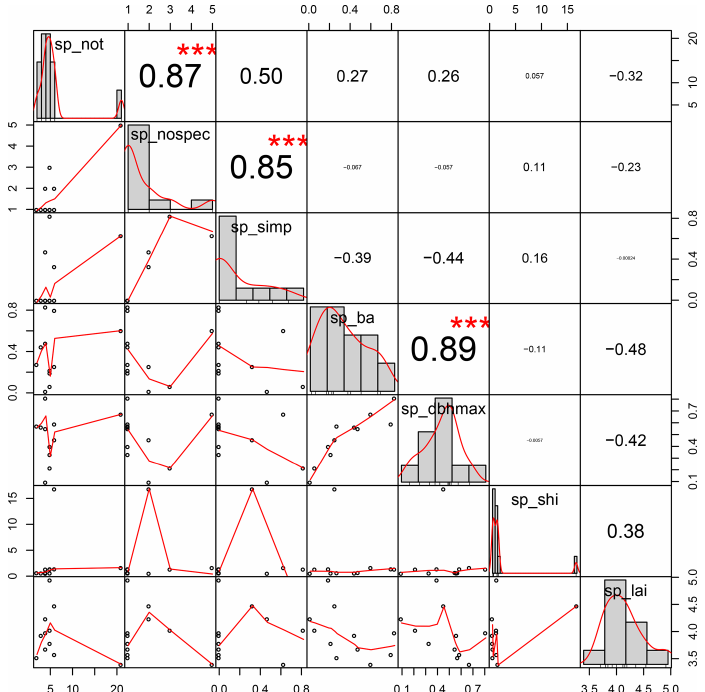
Figure A3. Distributions and correlations of variables included as fixed effects in the linear mixed effect models of subplot stemflow. “sp_not” is the number of trees in the subplot; “sp_nospec” is the number of species in the subplot; “sp_simp” is the Simpson diversity index of the subplot; “sp_ba” is the basal area of the subplot; “sp_dbhmax” is the DBH of the biggest tree on the subplot; “sp_shi” is the size heterogeneity index of the subplot; “sp_lai” is the subplot LAI; DBH is the diameter at breast height; LAI is the leaf area